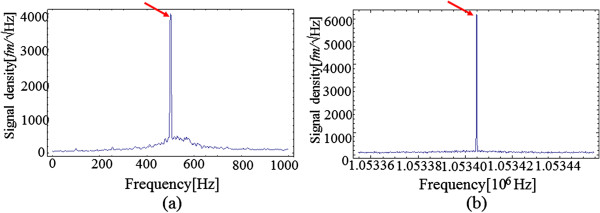
Modulation signal spectrums of FM- and HAM-KPFM detected signals at a modulation amplitude of 150 mV (a,b).VDC = -100 mV, A = 6.5 nm, Δf = -20Hz, f1st = 165 KHz, f2nd =1.0089 MHz. fmod = 500 Hz for FM-KPFM.